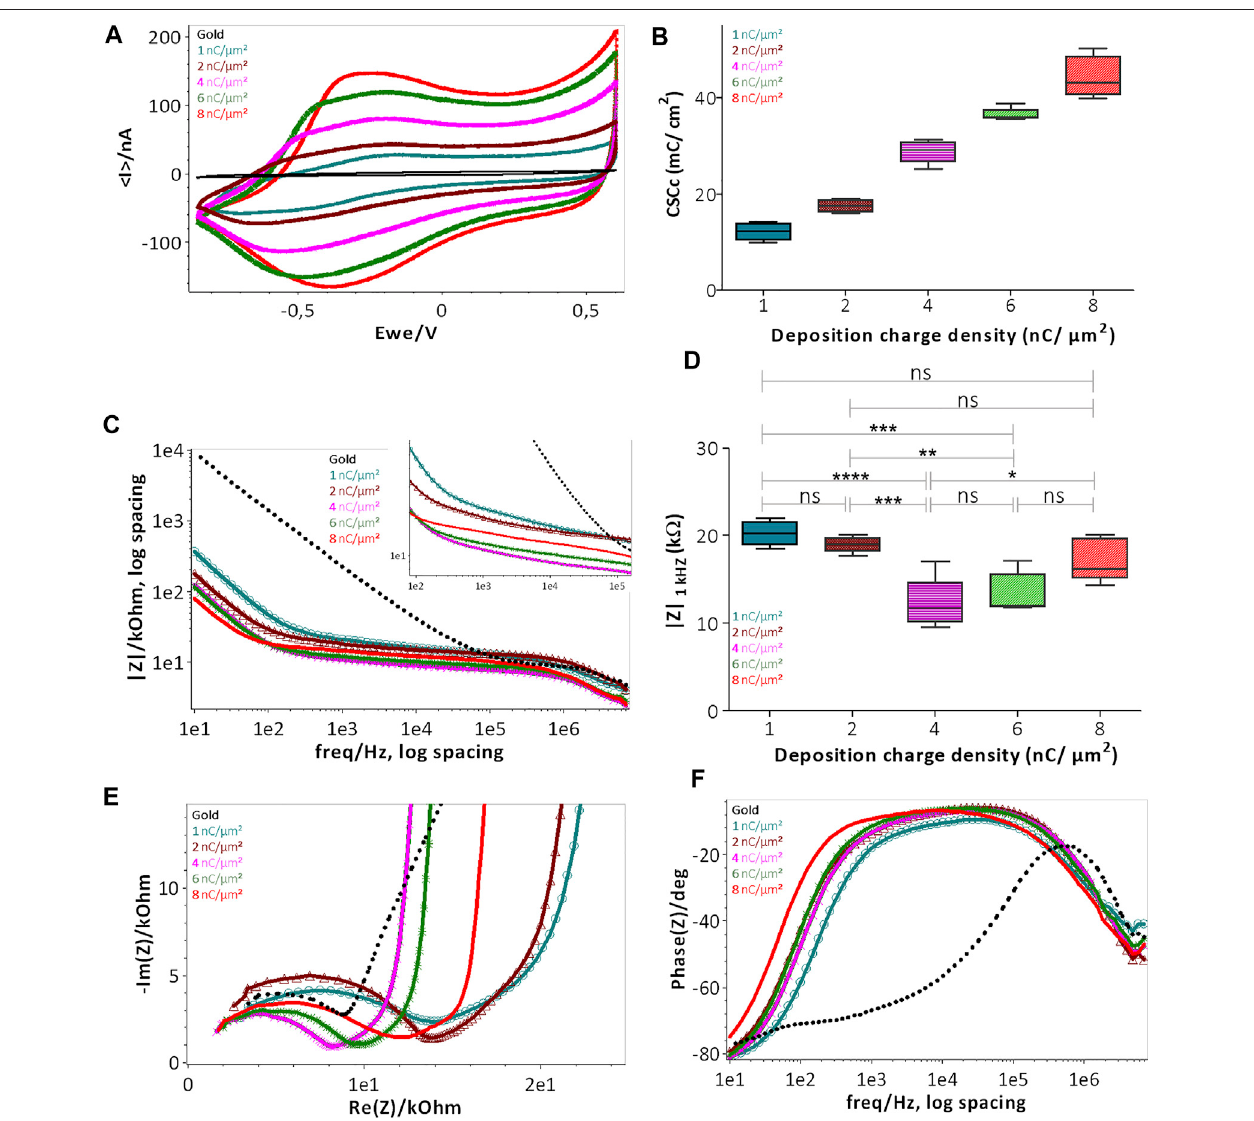
FIGURE 4 | Electrochemical characterization of PEDOT-CNF composite deposited on fl exible gold surface with different surface charge densities: (A) CSCc measurementsbyCVinaCSFat200 mV/svs.Ag/AgClrefelectrode; (B) PlotrepresentingtheevolutionofCSCcwithrespecttothedepositionchargedensity; (C) Bode plot representing the |Z| vs. frequency over a frequency range of 10 Hz to 7 kHz in aCSF at 0 V vs. Ag/AgCl ref electrode; (D) Plot of impedance |Z| 1 kHz responses vs depositionchargedensity.Thestatisticaldifferencesbetweendepositionconditionswereassessed byANOVA followedbyTukey ’ sposthoc test, where****,***,** andnsrepresent p < 0.0001, p < 0.001, p < 0.01andnosigni fi cantdifference,respectively( n (cid:2) 5); (E) Nyquistplotsand (F) phaseanglemeasurementsobtainedbyEIS. Depositionchargedensityconditionswererepresentedindifferentcolors,alongwiththeplaingoldelectrode(blackcolor)intheaboveallgraphs(Forinterpretationofthe references to colors in this fi gure legend, the reader is referred to the web version of this article).